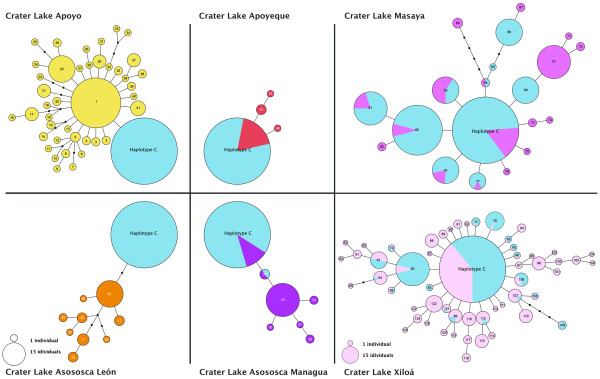
Unrooted haplotype networks of the complete mtDNA control region of cichlids of the Midas Cichlid species complex from six crater lakes in Nicaragua. Circles represent unique DNA sequences, and their size reflects the number of individuals sharing a particular haplotype (see scale; note that scale is different for crater Lake Xiloá). Colors refer to different lakes, light blue represents in each case fish from elsewhere outside the given crater lake. Connections between haplotypes represent mutational steps. The central haplotype 'C', is the most common haplotype that is found in the large lakes and some of the crater lake populations.